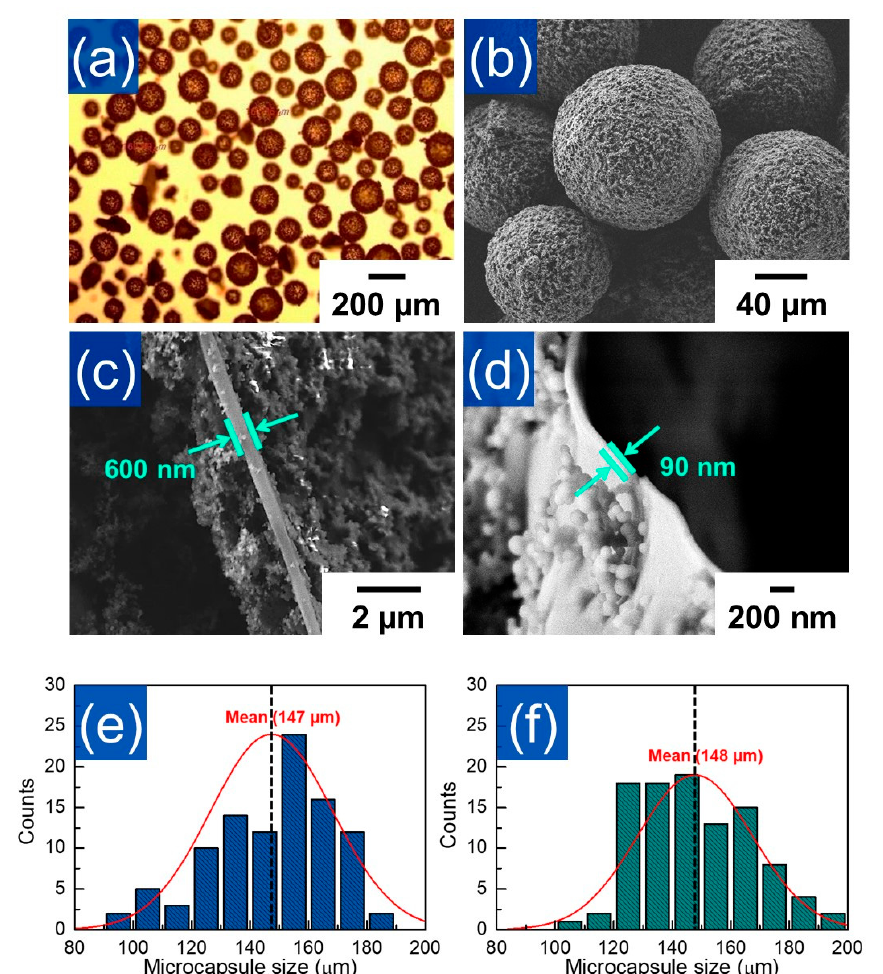
Figure 2. ( a ) Optical microscopy and ( b ) FE-SEM images of the mechanically-enhanced UF microcapsules. The shell thickness FE-SEM images of ( c ) mechanically-enhanced UF microcapsules and ( d ) conventional UF microcapsules. The size distributions of ( e ) mechanically-enhanced and ( f ) conventionally prepared UF microcapsules. Standard normal distribution curves are